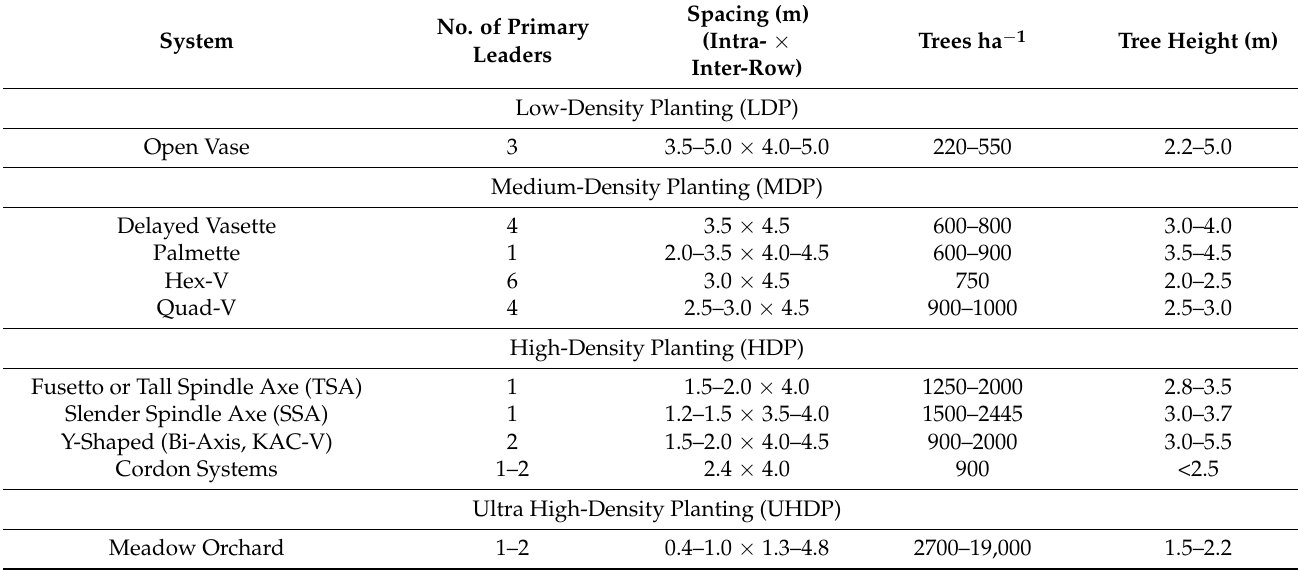
Table 2. Training systems and their associated orchard design